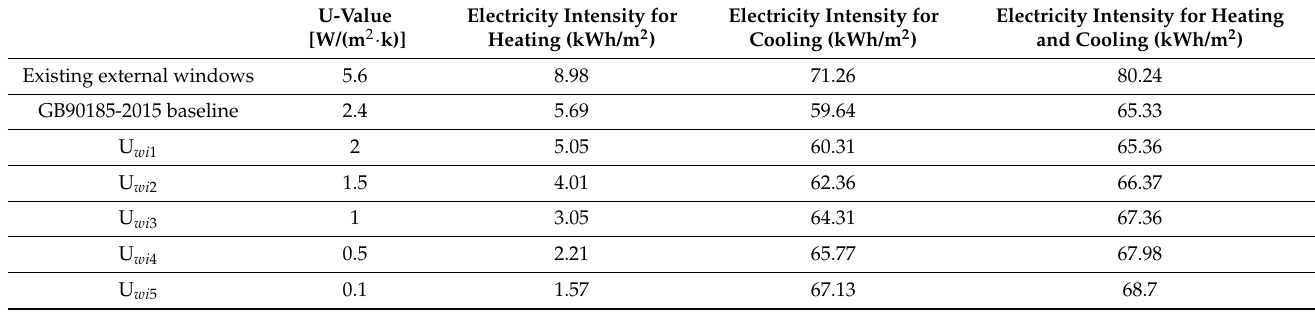
Table 9. Simulation results of different U-values for window energy retrofitting.